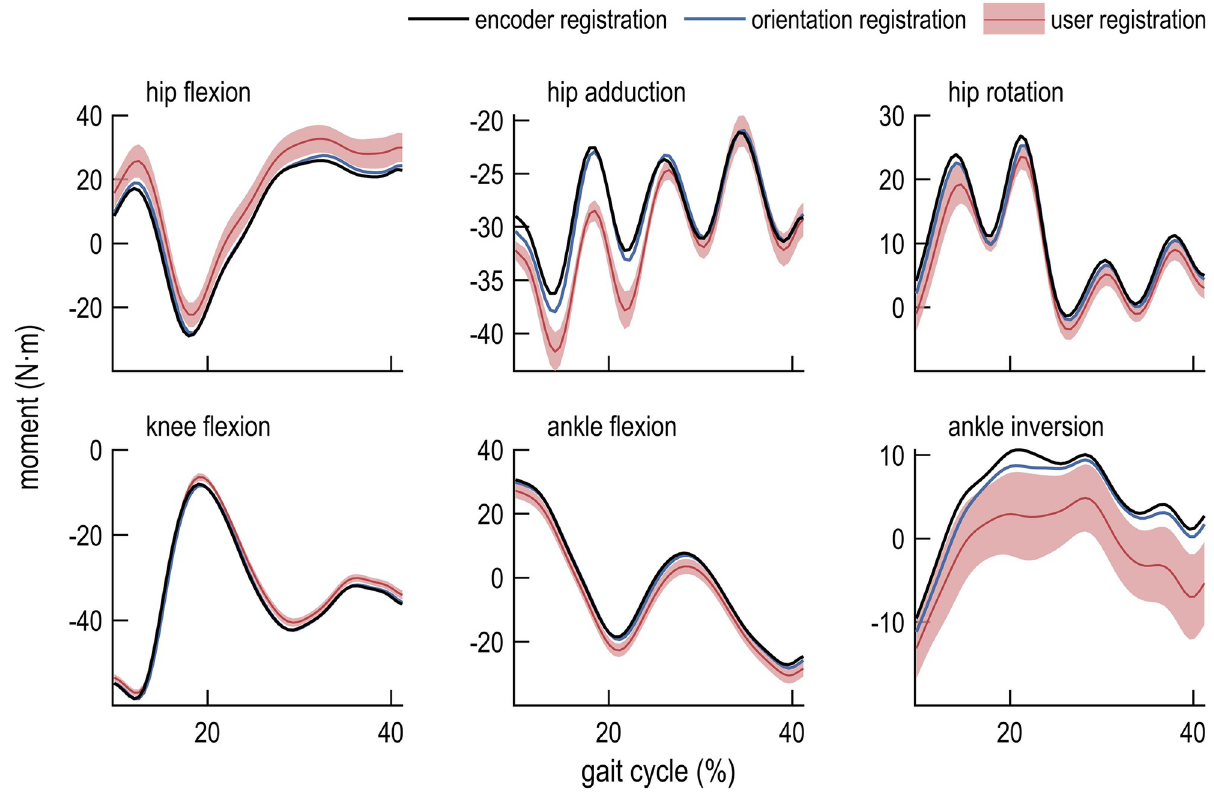
Fig 5. Inverse dynamics computed using three registration methods. Joint moments were computed during single-leg stance using encoder registration (black line), orientation registration (blue line), and user registration (mean, red line; standard deviation, shaded).